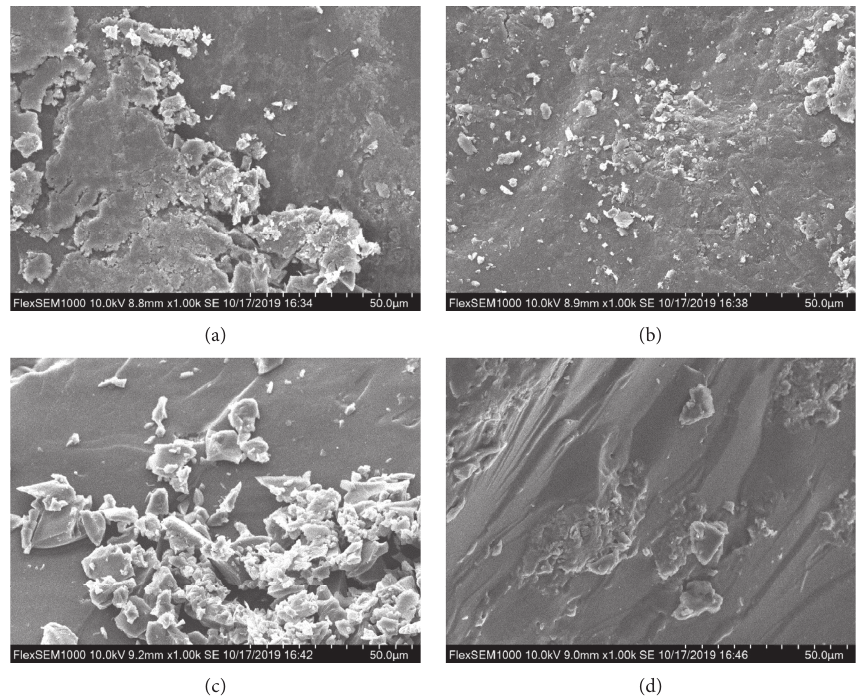
Figure 4: Mesostructures of the hard coal in the different coal seams. (a) No.1 hard coal in the No. 4 coal seam. (b) No. 2 hard coal in No. 4 coal seam. (c) No. 1 hard coal in the No. 13 coal seam. (d) No. 2 hard coal in the No. 13 coal